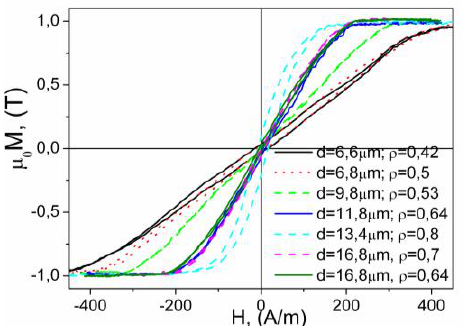
Figure 5. Effect of sample geometry (  ratio) on magnetic anisotropy field, H